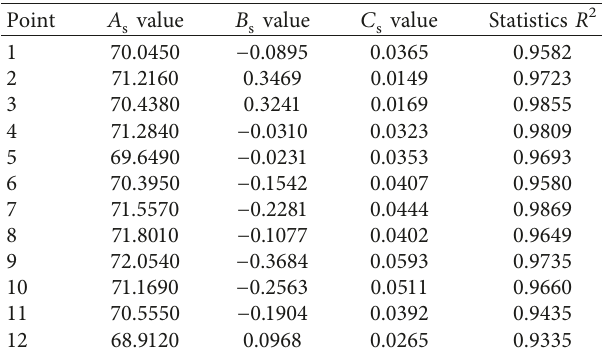
Table 6: Fit parameters between radiation noise and rotation speed.